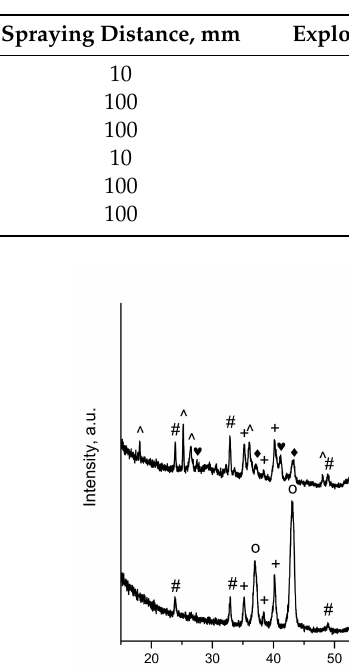
Table 3. Phase composition of the coatings obtained by detonation spraying of titanium using air as a carrier gas [29].